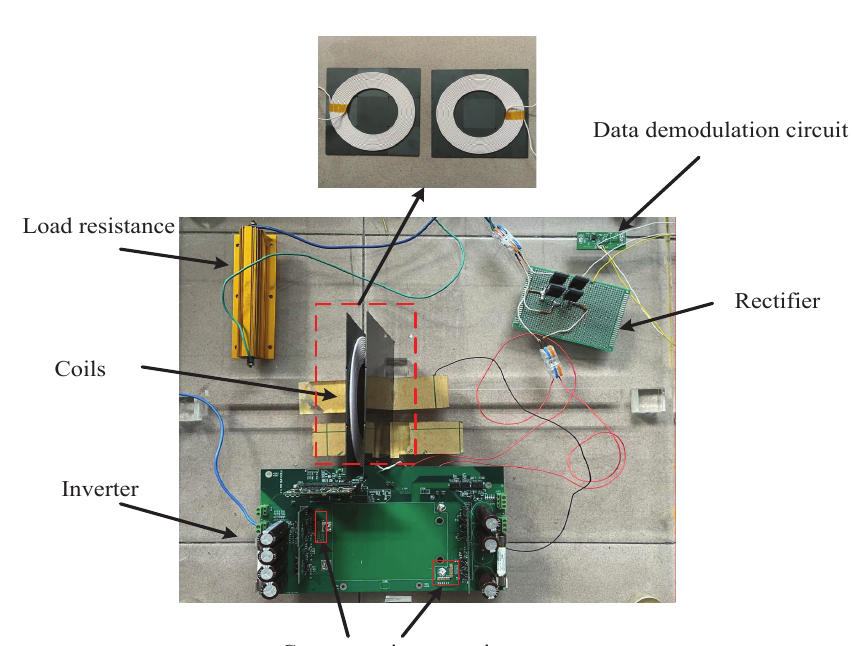
Figure 6. Picture of the prototype.